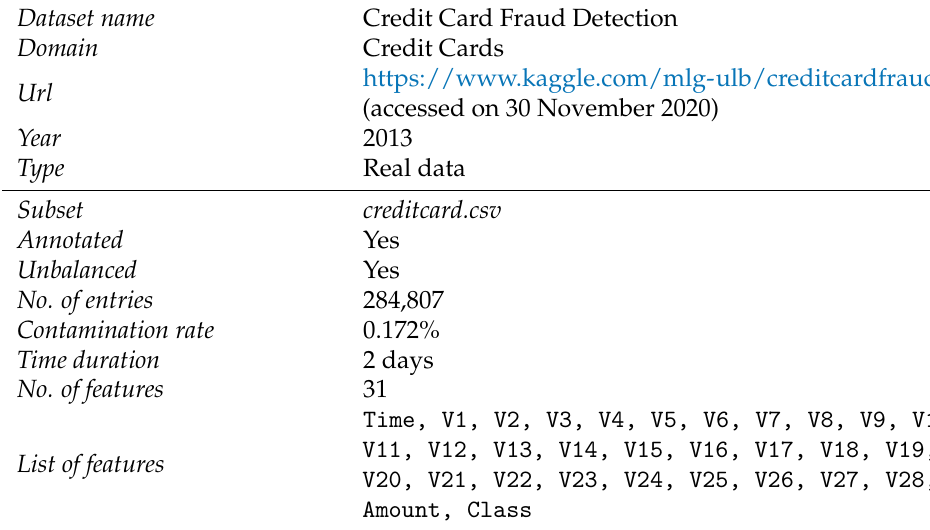
Table 4. Credit Card Fraud Detection dataset